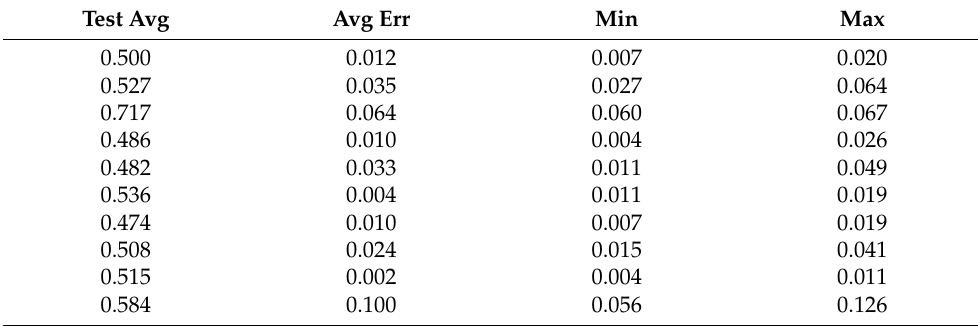
Table A6. Set 1, trials 1–10 data (actual PR value).